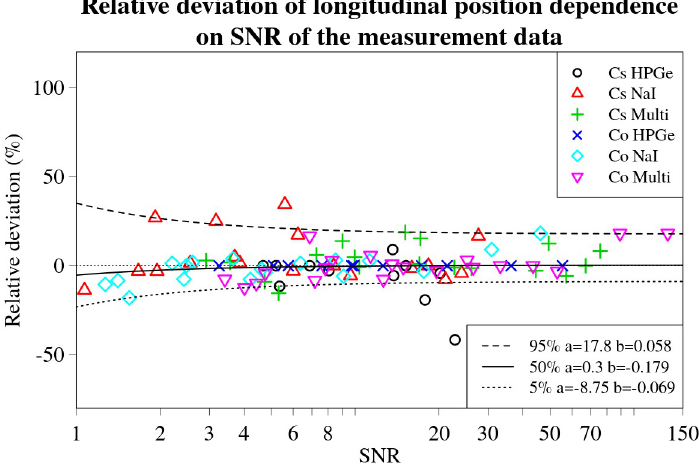
Fig 17. Longitudinal position relative deviation values for every experimental set-up, detector and source combination plotted against the respective SNR values. Black dashed line denotes the 5%, solid line—50% and dotted line—95% (from top to bottom) curves denoting corresponding quantile dependencies on SNR of the data, obtained using non-linear quantile regression. Fitted parameters a and b of the lines are displayed in a legend on the right.